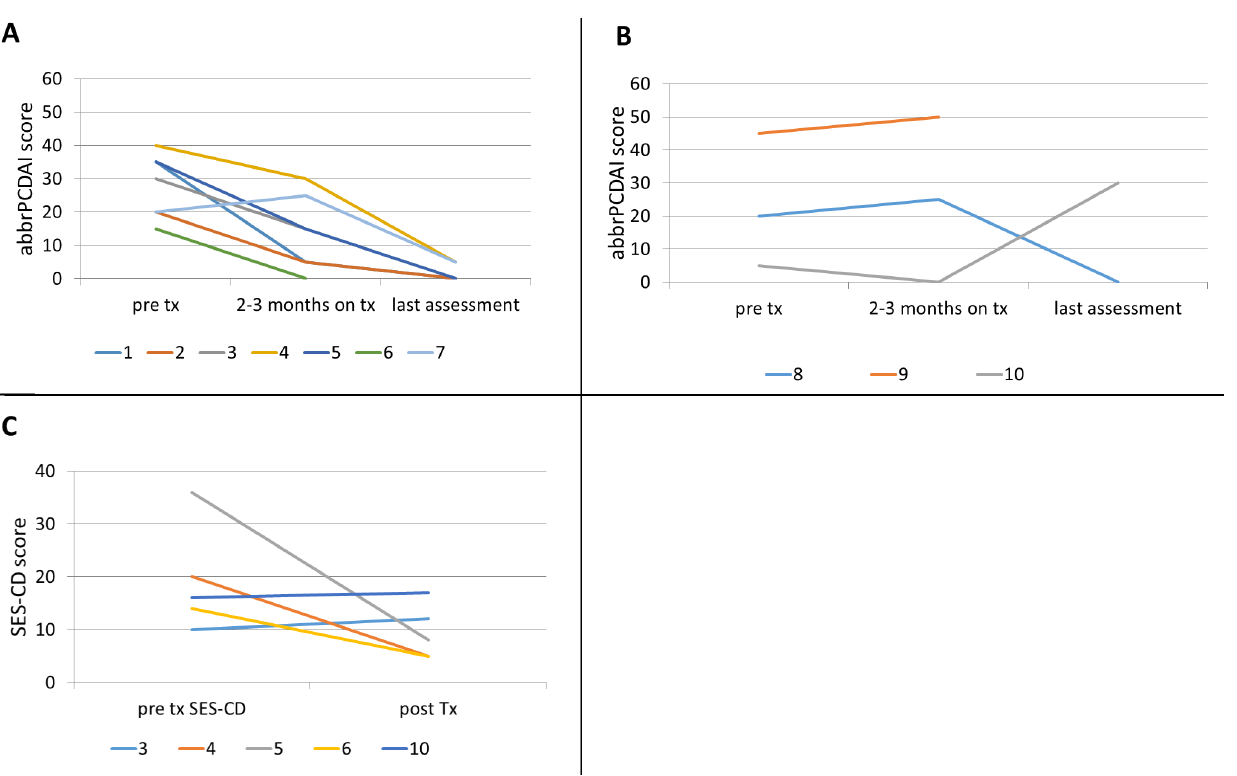
Figure 1. Clinical and endoscopic response. Abbreviated-pediatric Crohn’s disease activity index in patients with ( A ) augmented ustekinumab dosing and ( B ) Q8 dosing; ( C ) simple endoscopic score-Crohn’s disease (SES-CD) pre and post-ustekinumab initiation.